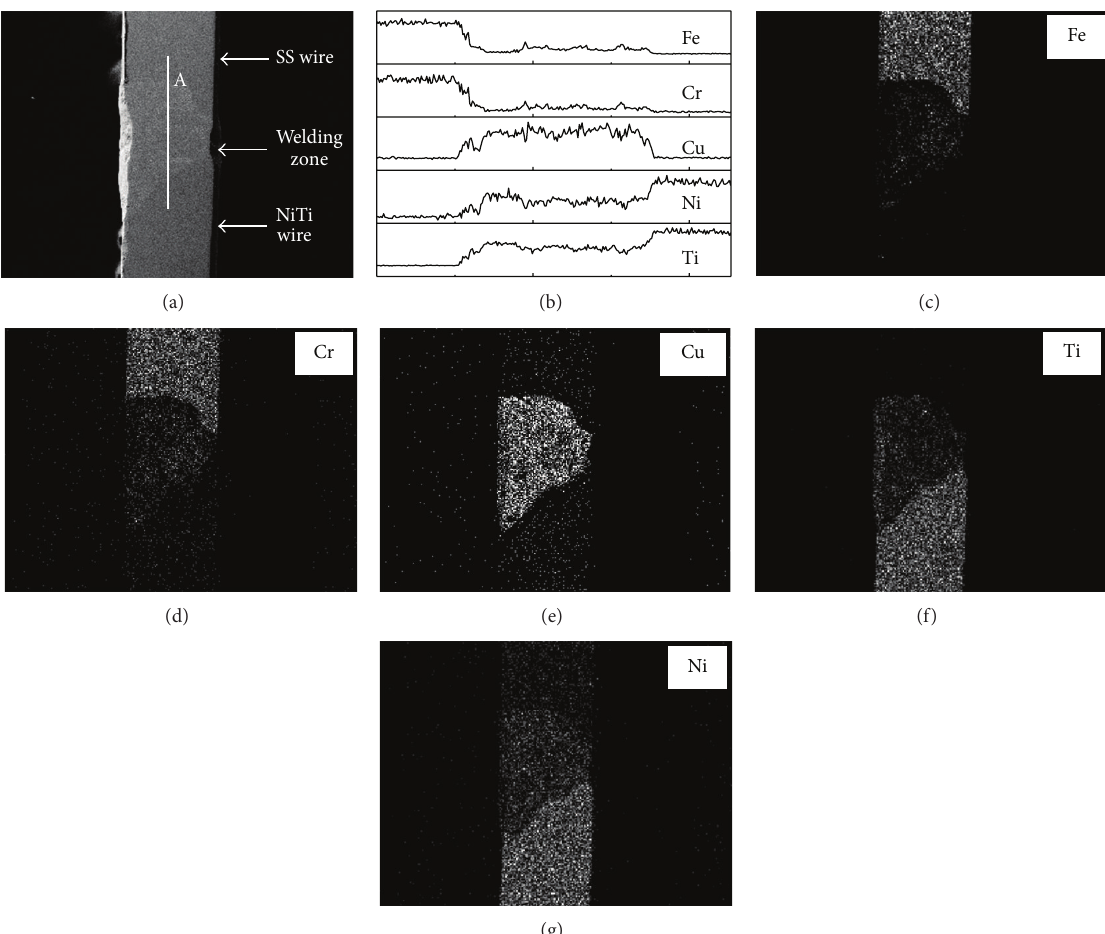
Figure 2: (a) SEM surface morphologies of the welded composite arch wire; (b) EDS line analysis of the welded composite arch wire; ((c)–(g)) map EDS analysis of the welded composite arch